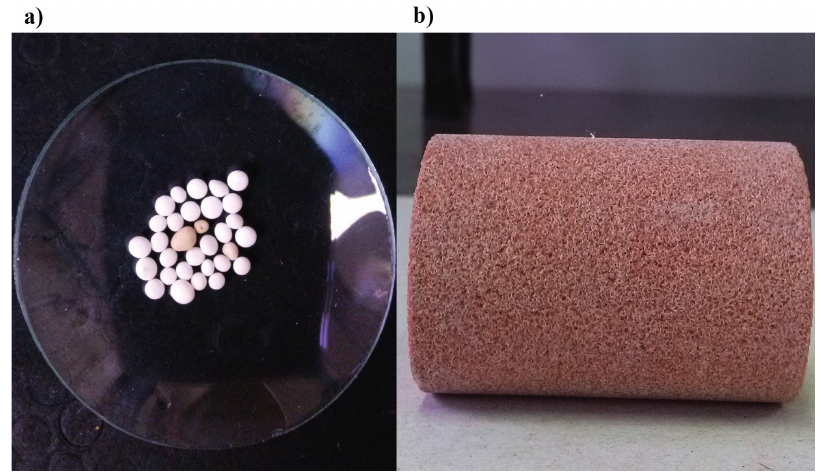
) used in static test; ( b ) core 4